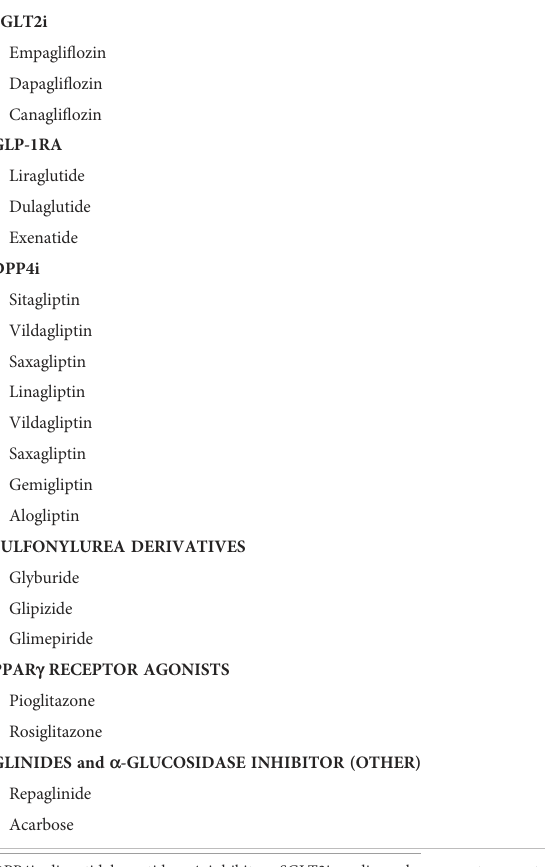
TABLE 1 Grouping of comparators in the present